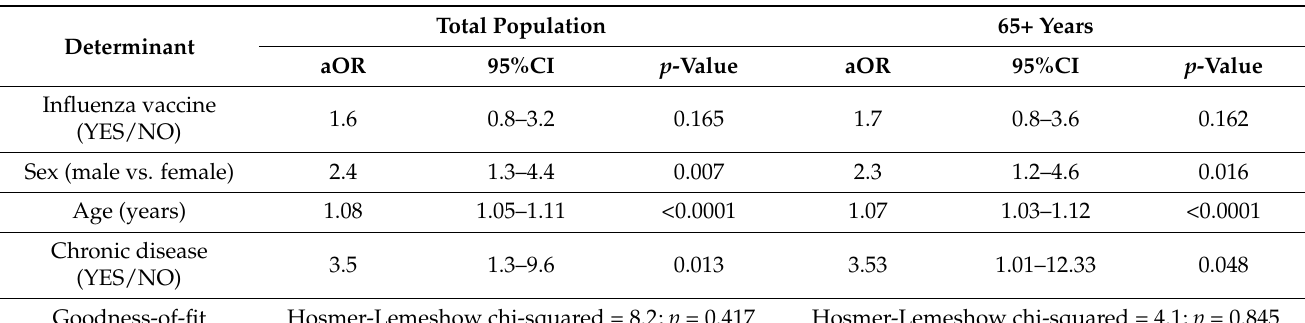
Table 2. The determinants of death according to multivariate logistic regression models for the total population and patients 65+ years of